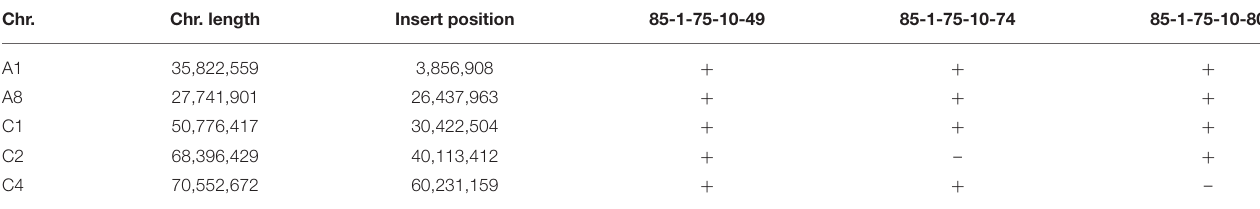
TABLE 2 | Potential insertion sites in three progeny of 86-1-75 by genome resequencing analysis. Chr.